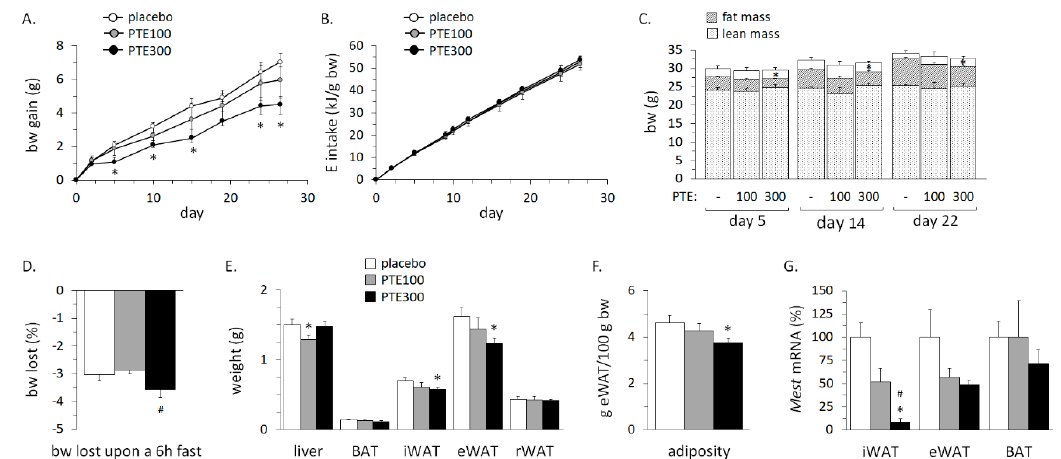
Figure 1. Phaeodactylum tricornutum ethanolic extract (PTE) ameliorates fat deposition in C57BL/6J mice fed with a high fat diet (HFD). Evolution of body weight (bw) gain ( A ), cumulative energy intake from food ( B ), and body composition ( C ) from day 1 to 26 of dietary challenge. Body weight lost upon a 6 h fast, on day 22 ( D ). Liver, interscapular brown adipose tissue (BAT), and inguinal, epididymal, and retroperitoneal white adipose tissue (iWAT, eWAT, and rWAT) weights ( E ), adiposity as eWAT weight as percent body weight ( F ), and mRNA expression levels of Mest in iWAT, eWAT, and BAT ( G ) at the end of the experiment. HFD-fed mice received daily an oral dose of PTE (100 mg or 300 mg/kg bw) or placebo (olive oil:water, 2:1, v : v ) for 26 days. Data are mean ± SEM of 5–6 male mice/group. To compare between two groups, the non-parametric Mann–Whitney U test was used: *, different ( p < 0.05) from vehicle; and #, different ( p < 0.05) between doses.